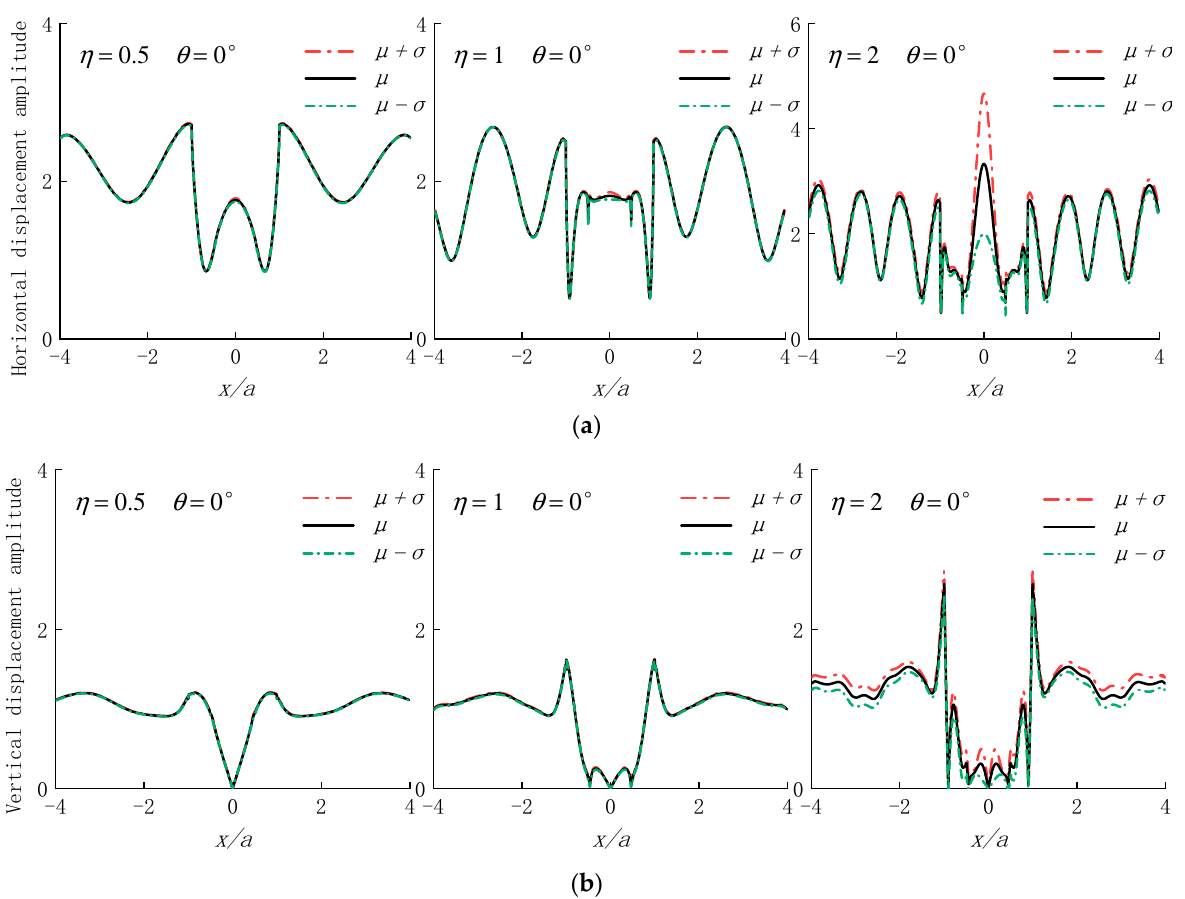
Figure 3. Effect of porosity randomness on surface displacement amplitude in sedimentary river valleys (𝜃 = 0°) . ( a ) Horizontal displacement; ( b ) Vertical displacement.